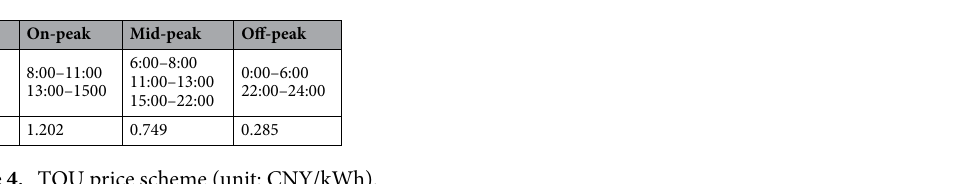
Table 4. TOU price scheme (unit: